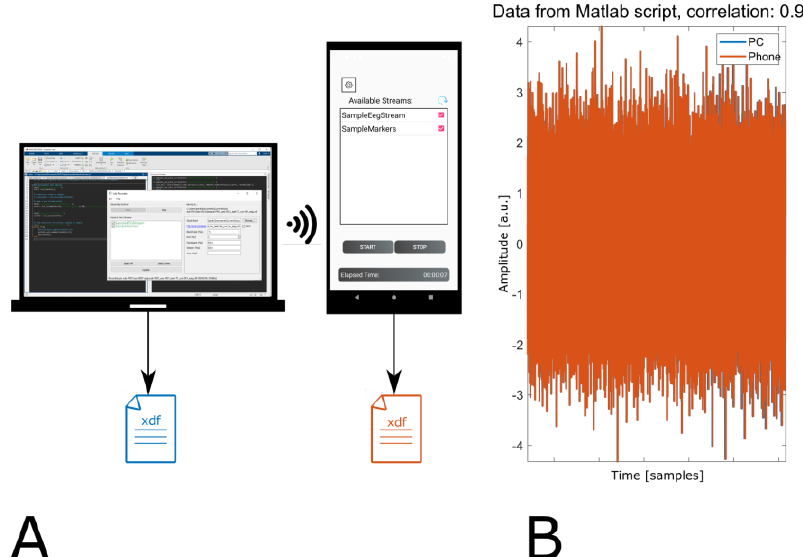
Figure 3. ( A ) Illustration of scenario 2. A PC streamed data which was recorded by Record-a on phone and LabRecorder on PC simultaneously. ( B ) 9.5 minutes of data from the same channel recorded on the PC and on the phone.